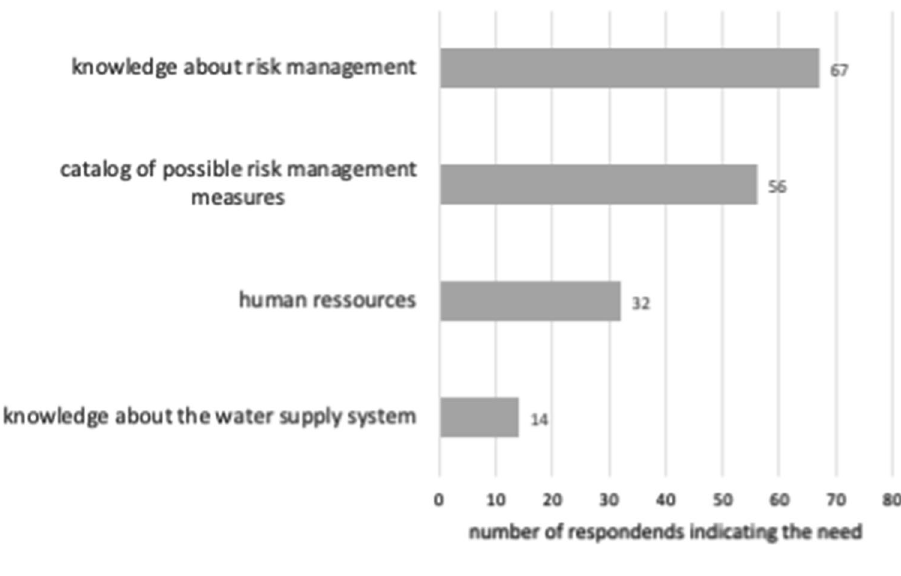
Fig. 1 Distribution of